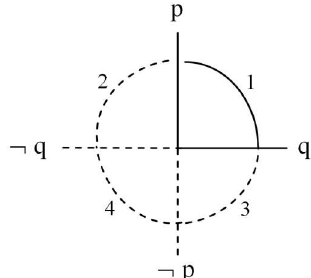
Table 2: Truth-table of conjunctive Graph 2: Truth-graph of conjunctive expression